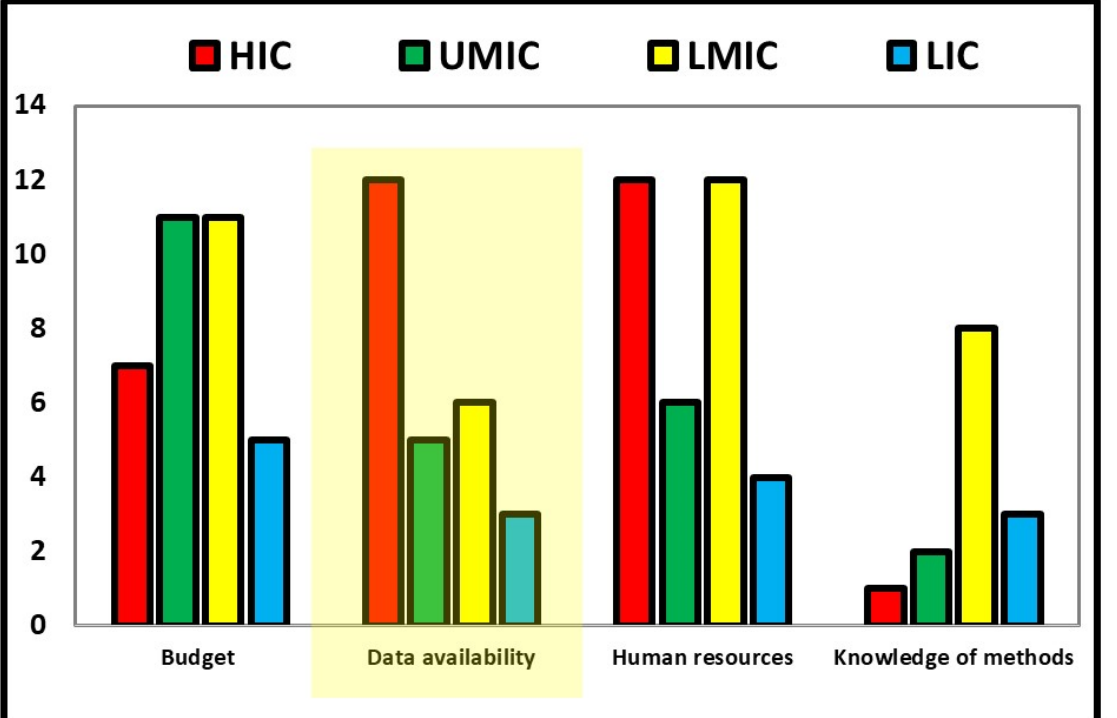
Figure 1. Principal barriers of conducting Health Technology Assessment in countries. HIC: high-income countries; UMIC: upper-middle-income countries; LMIC, lower-middle-income countries; LIC: low-income countries. Source: WHO Health Technology Assessment Survey 2020–2021.